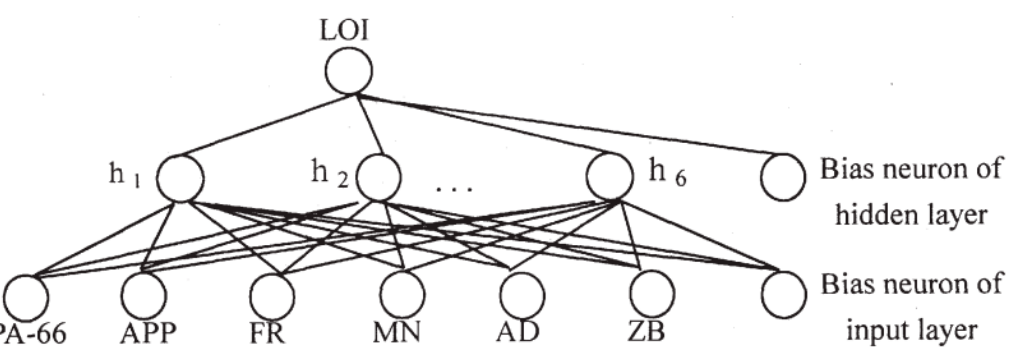
Table 5. A comparison of prediction capability between multiple nonlinear regression (MNLR) analysis and the ANN model [101].